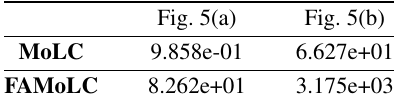
Table 4. Maximal values of the contrast matrices. Fig. 5(a) Fig.